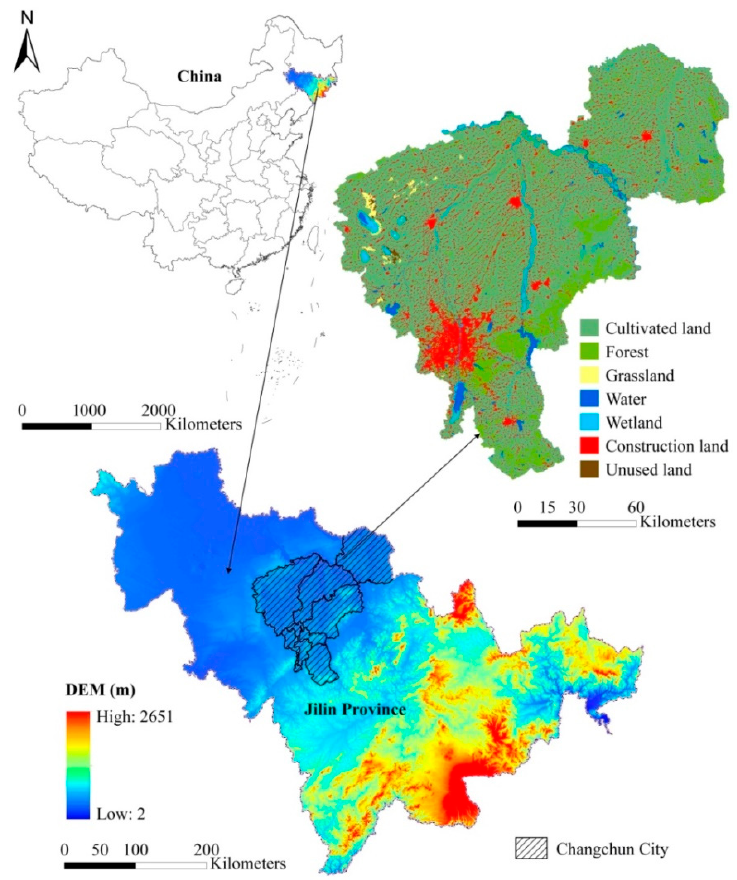
Figure 1. Geographic location of the study area and spatial pattern of land use in 2020.